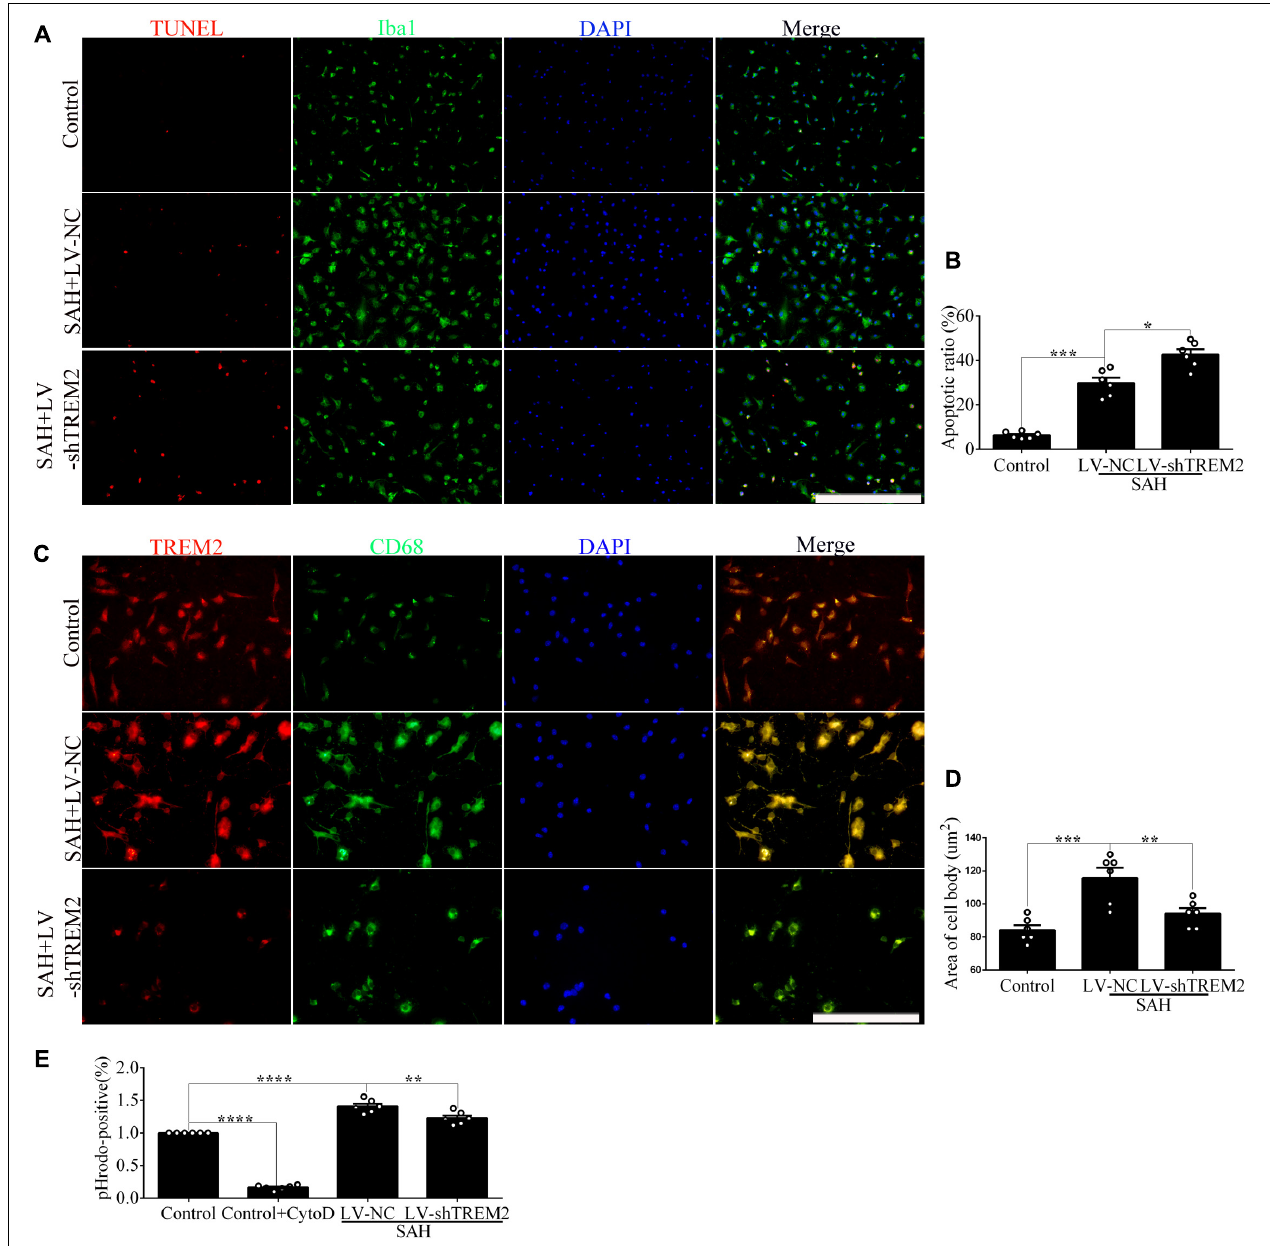
FIGURE 3 | Triggering receptor expressed on myeloid cells 2 ( TREM2 ) mediates the microglial survival and phagocytic capacity at 12 h following subarachnoid hemorrhage (SAH). (A,B) Immunofluorescence labeling and quantitative apoptotic percentage of the microglia were revealed in vitro . (C,D) Double immunofluorescence staining of TREM2 and CD68 was detected and quantified. (E) The phagocytic capacity was evaluated using Escherichia coli conjugated to pHrodo. These data are shown as mean ± SEM (* p < 0.05, **p < 0.01, *** p < 0.001, **** p < 0.001; A , scale bar = 50 µ m; C , scale bar = 25 µ m).